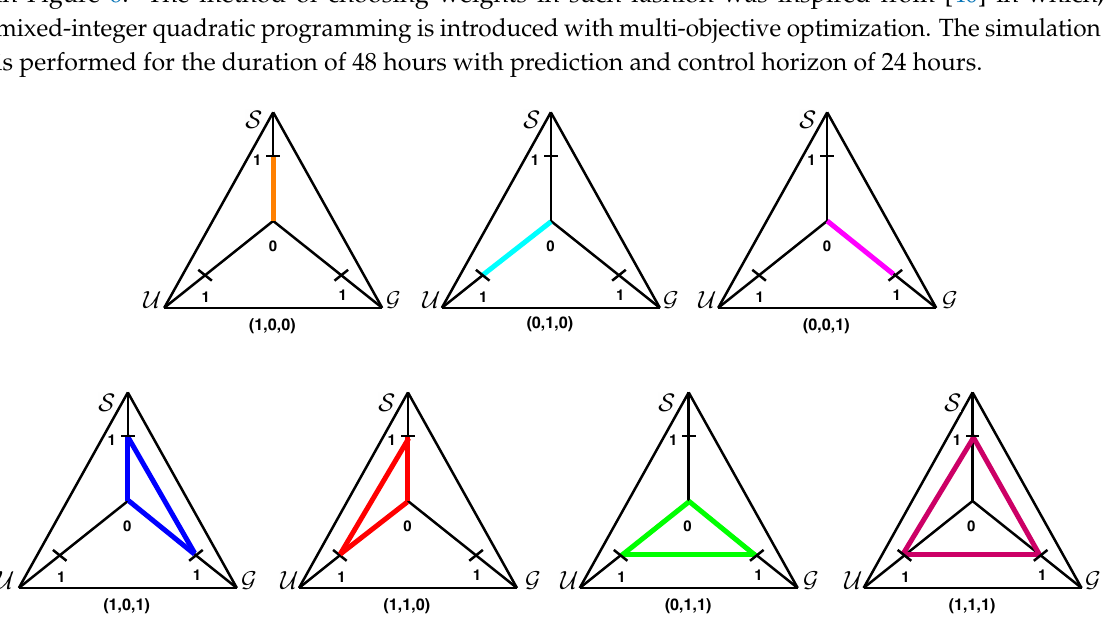
Figure 6. Objective weights, S , U and G for various extreme